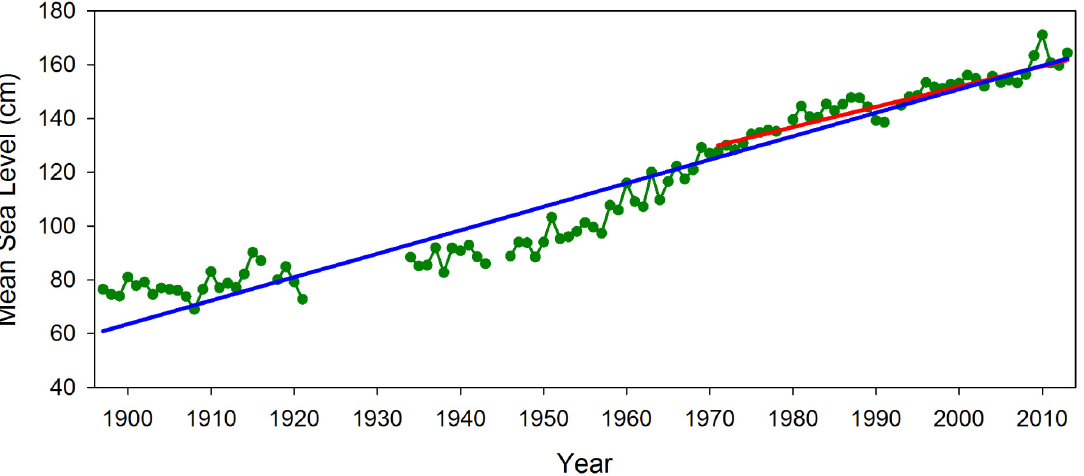
Figure 2. Annual values of mean sea-level at the Porto Corsini tide gauge in Marina di Ravenna during 1897-2013. The blue line represents the long-term trend obtained by applying the least squares regression method over the entire time series, while the red one shows the trend during